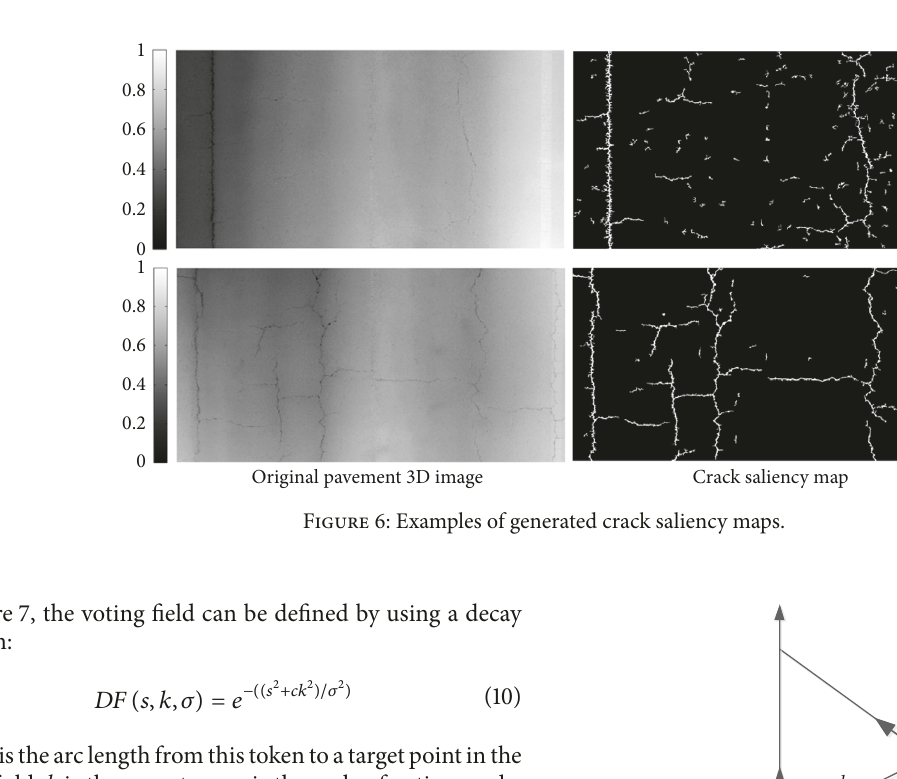
Figure 5: Steerable filters in SMFB.